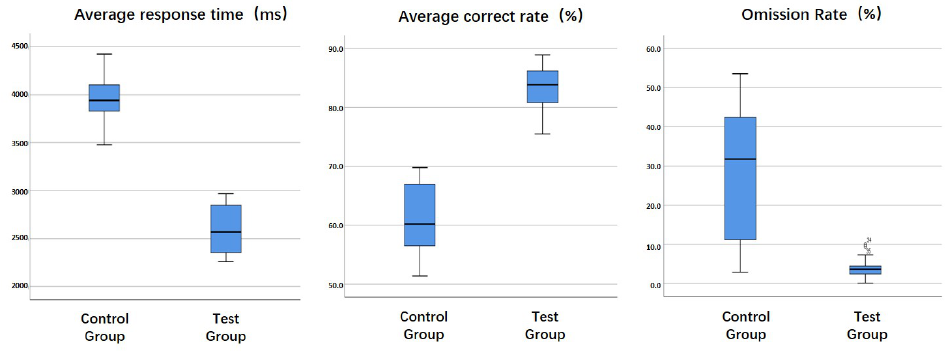
Figure 8. Experimental data box diagram.